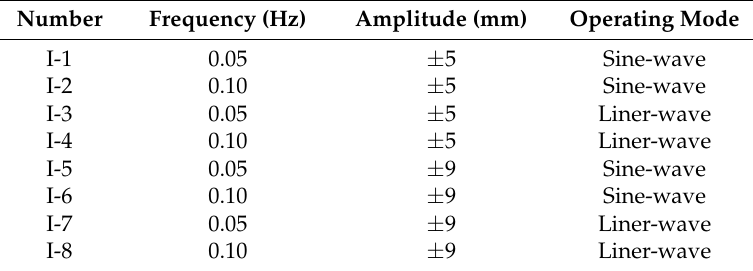
Table 5. Experimental parameters of artificial target tests.